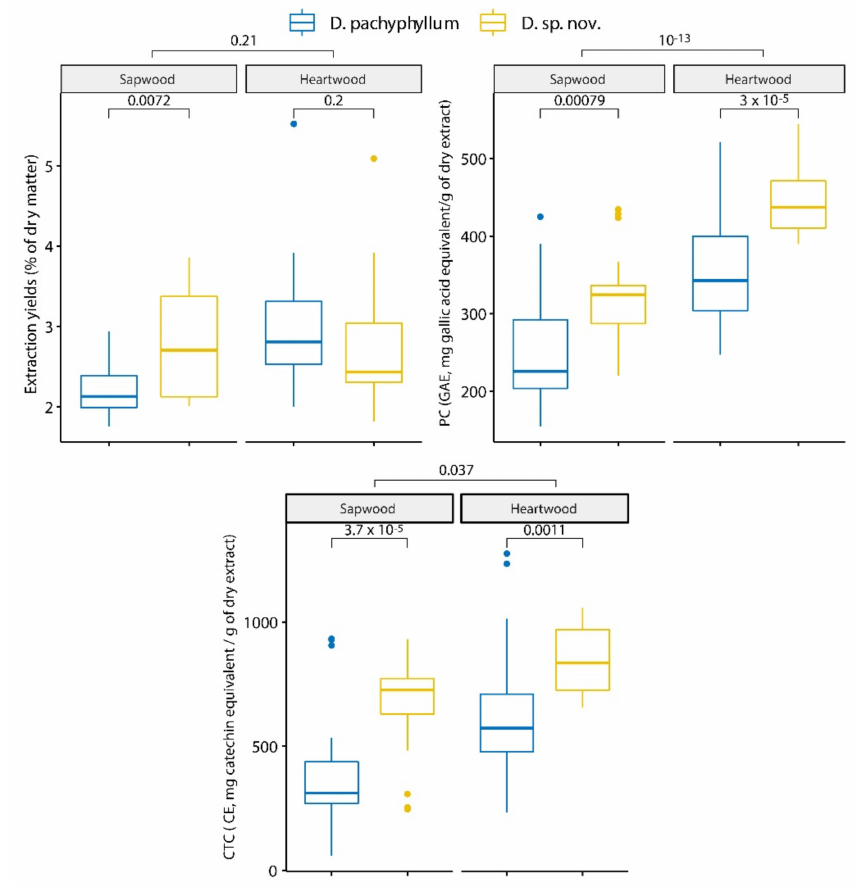
Figure 5. Extract yields and extract composition variation in heartwood and sapwood among the different studied species. p -values concerning heartwood and sapwood are related to ANOVA test (Phenolic content and Condensed tannin content) and Kruskal–Wallis test (Extraction yields); p -values that compare species are related to the t -test (Phenolic content and Condensed tannin content) and Wilcoxon’s test (Extraction